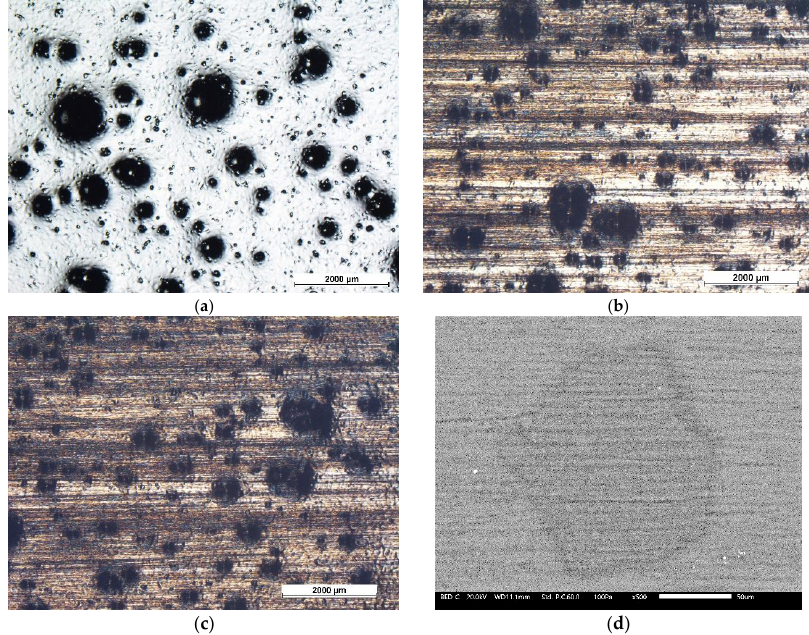
Figure 16. Optical stereomicroscope ( a – c ) and SEM ( d ) micrographs of sample SG surface morphology, taken ( a ) before the scrub test, ( b ) after 1000 cycles and ( c , d ) after 2000